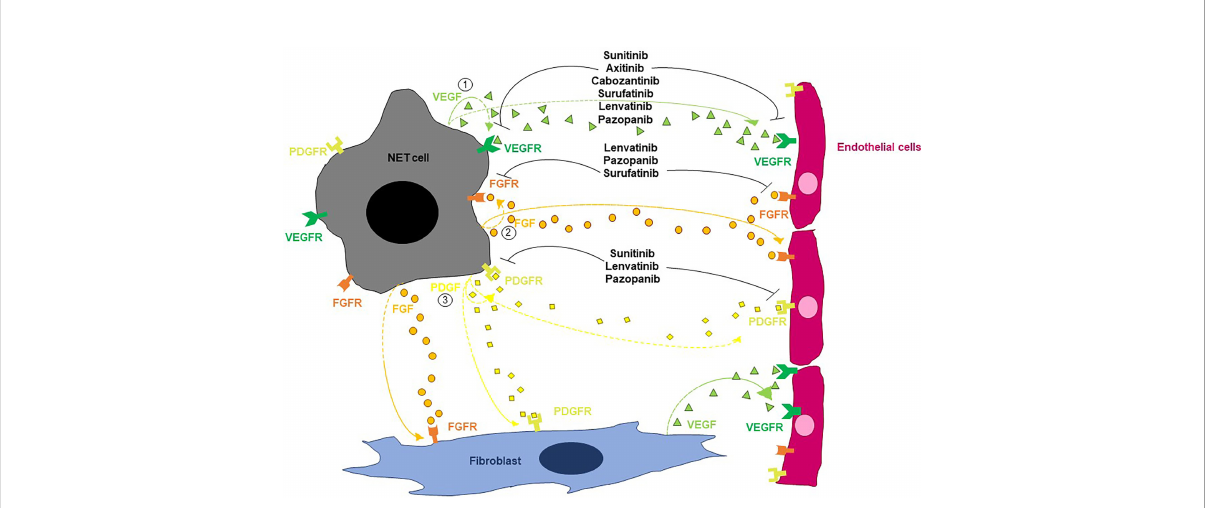
FIGURE 1 Schematic overview of the main pathways regulating angiogenesis in NETs. By acting on endothelial cells, VEGF stimulates both vascular endothelial mitogenesis and permeability. FGFs trigger endothelial cell migration, proliferation and differentiation as well as vessel formation. PDGF contributes to the angiogenic process by stimulating the recruitment of pericytes and the resulting vessel coverage. Multiple TKIs can interfere with the angiogenic process in